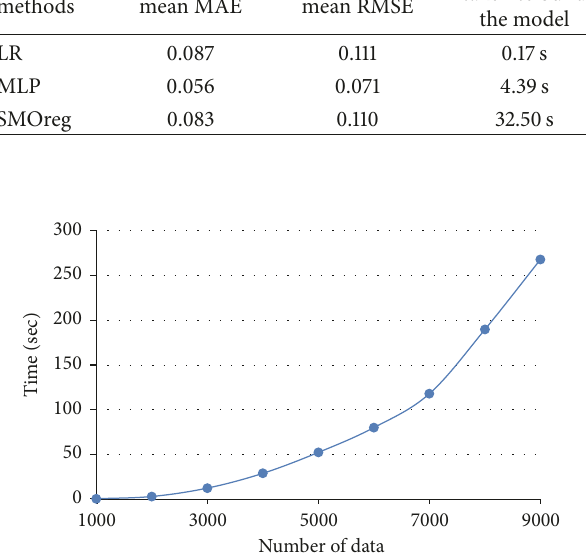
Figure 6: Time taken to build the model according to the number of data in the